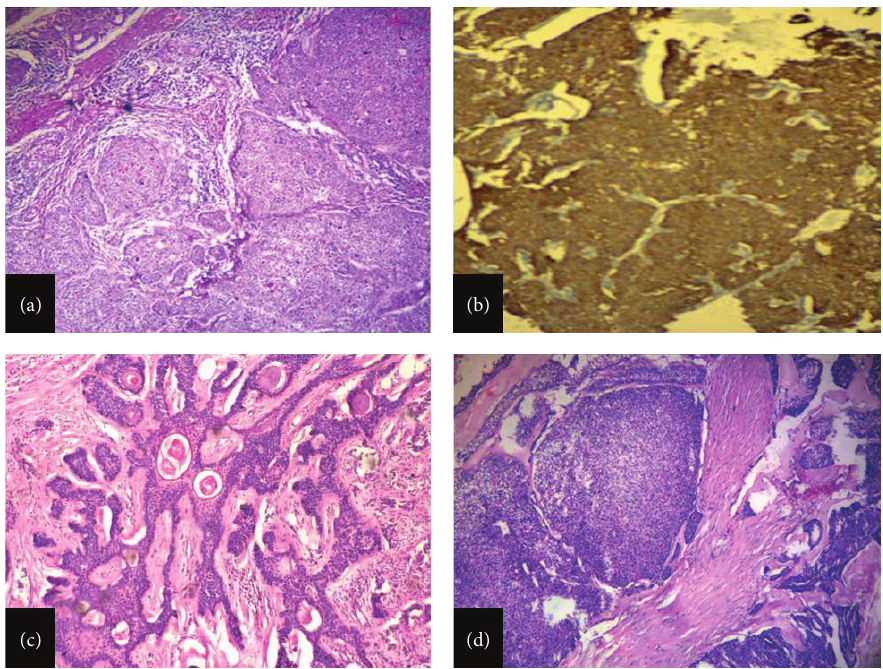
Figure 4: (a) Trichilemmal carcinoma, invasive tumour with solid pattern showing clear cells (H&E, × 50). (b) Trichilemmal carcinoma, showing pankeratin (AE1/3) positivity in the tumour islands (Immunoperoxidase, × 50). (c) Trichofolliculoma, showing keratin cysts lined by squamous epithelium emanating from which numerous secondary hair follicles are seen (H&E, × 50). (d) Sebaceous carcinoma, showing numerous irregular lobules with infiltrative growth in the dermis (H&E, × 50).